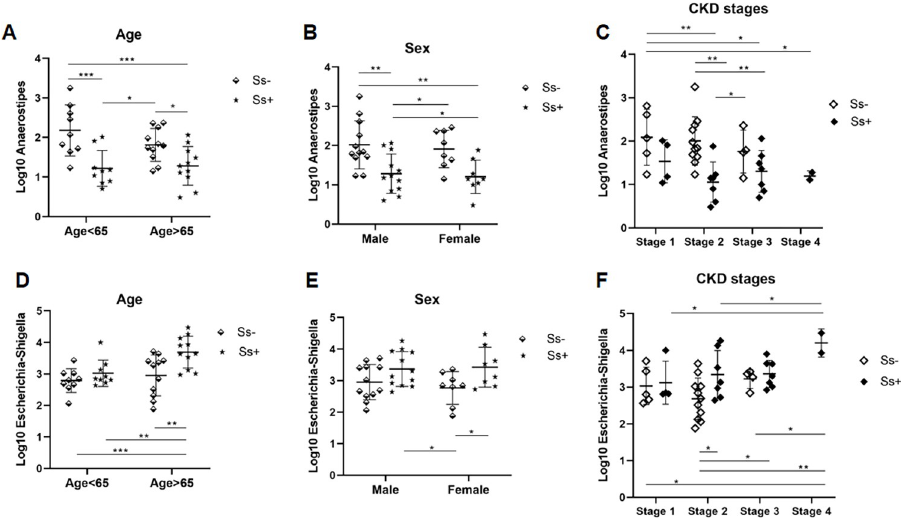
Fig 7. Opposing trends in abundance of two genera, Anaerostipes and Escherichia-Shigella . (A) and (D) Different trends related to age; (B) and (E) sex; (C) and (F) CKD stages. � P < 0.05, �� P < 0.01, ��� P < 0.001. Analysis of the difference among groups of sex, age and CKD stages based on one-way ANOVA